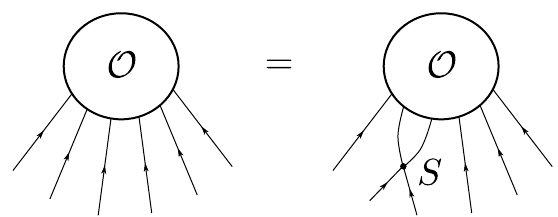
Figure 1. Graphical representation of the scattering